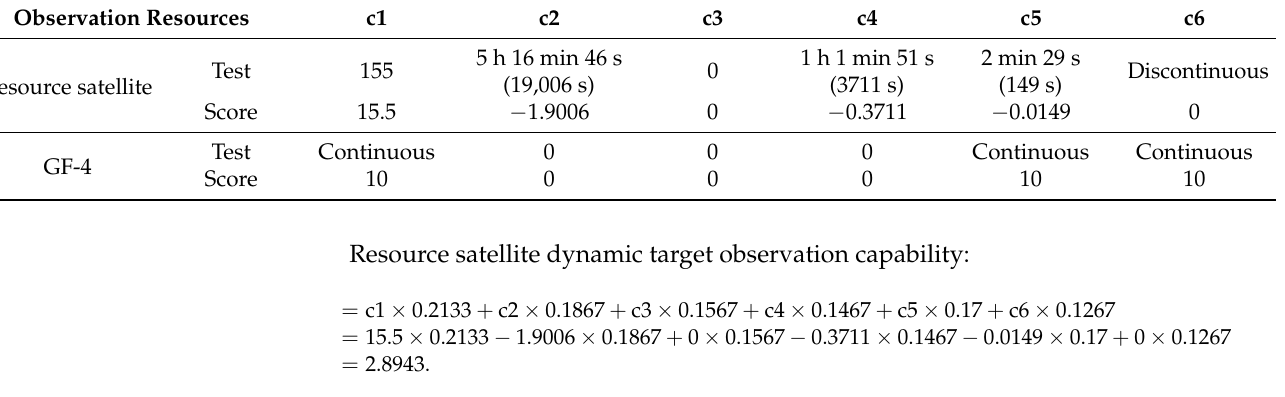
Figure 6. 2D diagram of the GF-resource satellite joint access to a moving target. Table 6. Improvement of observation capability of moving